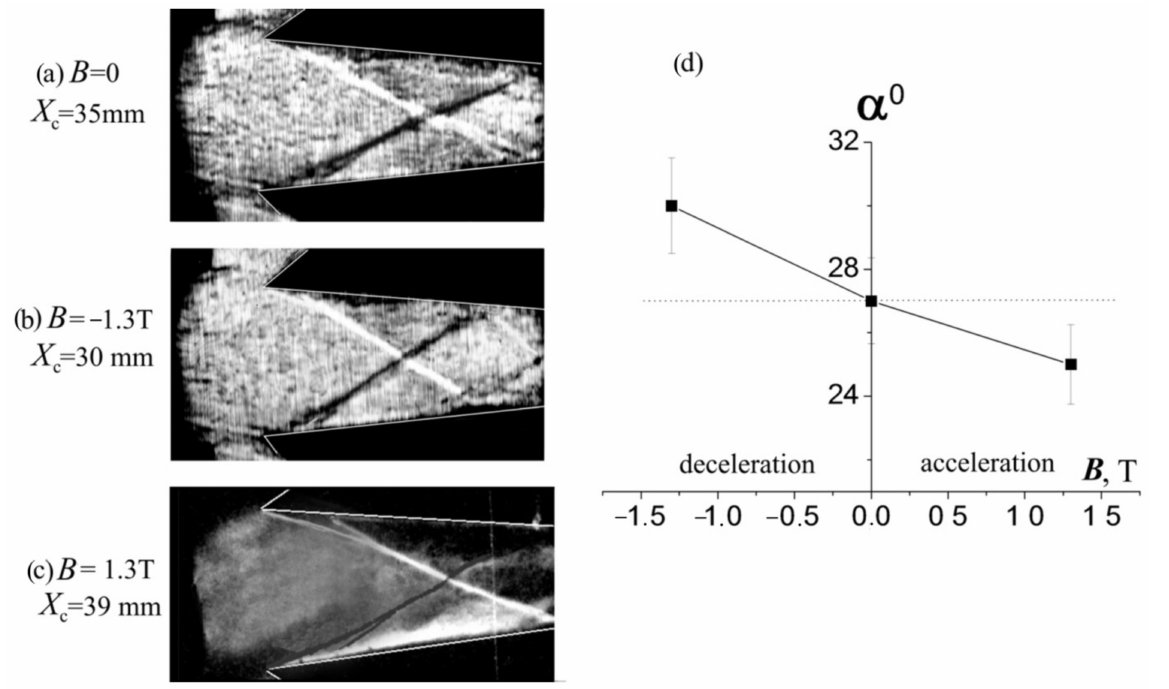
Figure 10. ( a – c ) Schlieren patterns of the flow; ( d ) Change in the angle of intersection of the attached shocks when changing the direction of magnetic